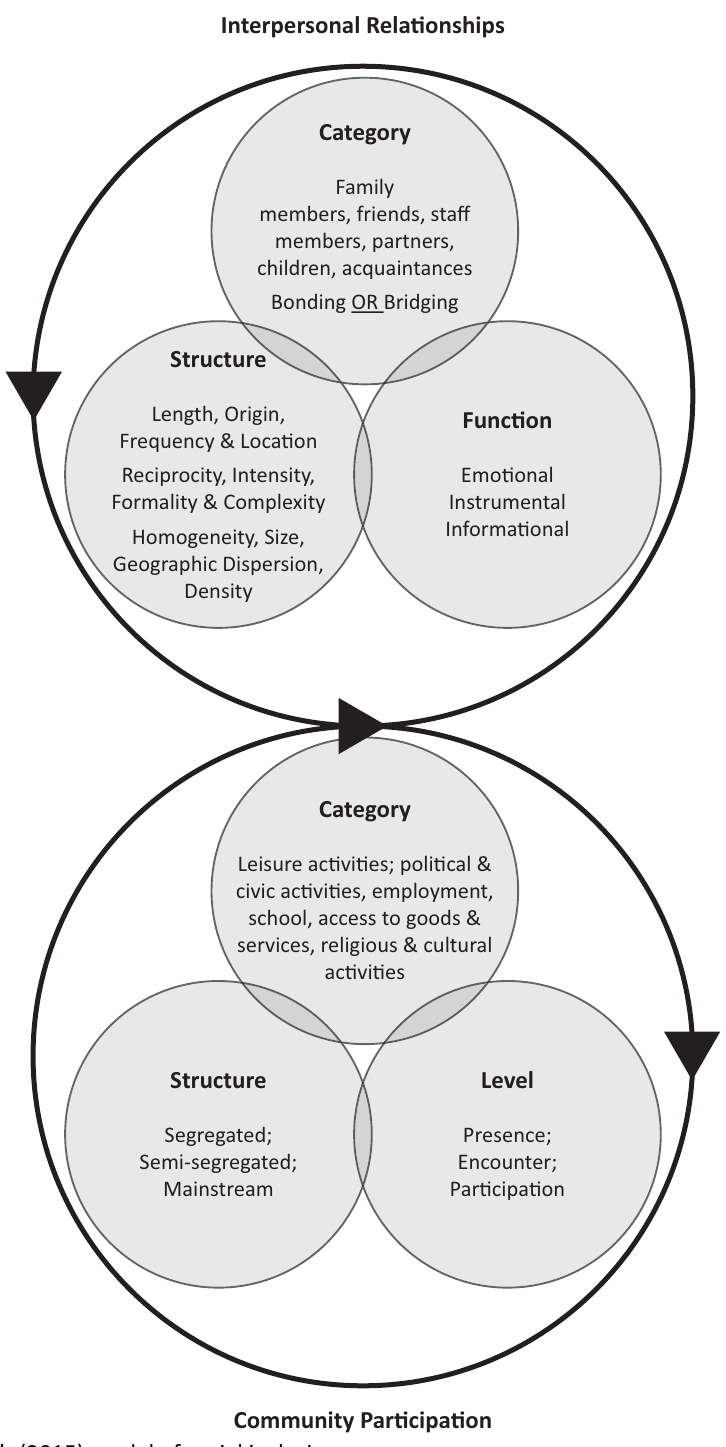
Figure 1. Simplican et al.’s (2015) model of social